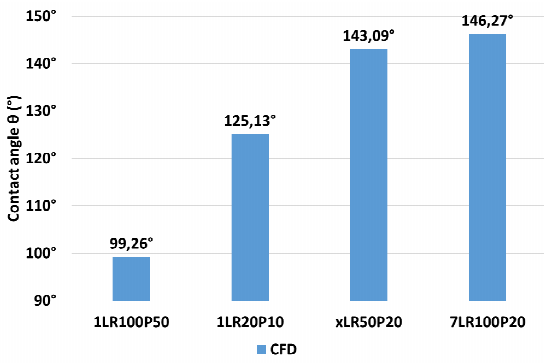
Fig. 8. Comparison of contact angle for different structures.